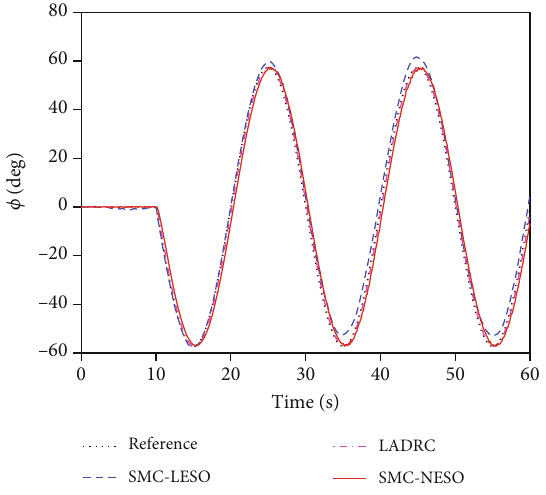
Figure 8: Result based on